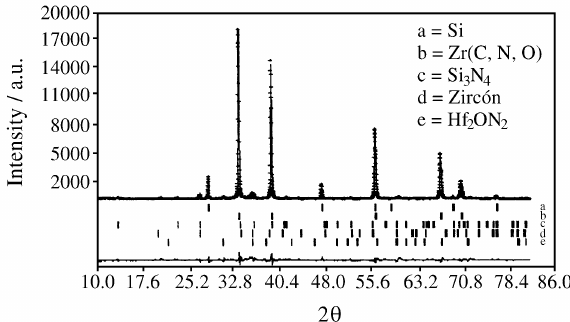
Figure 3. Rietveld analysis for sample Z4 treated at 1500 °C. (Reaction time: 120 min).